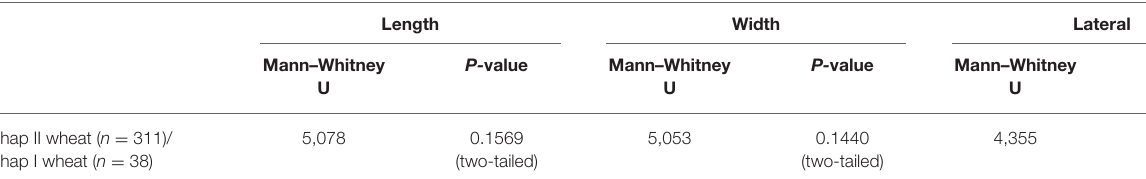
TABLE 2 | Wheat from Chap II in comparison to Chap I.